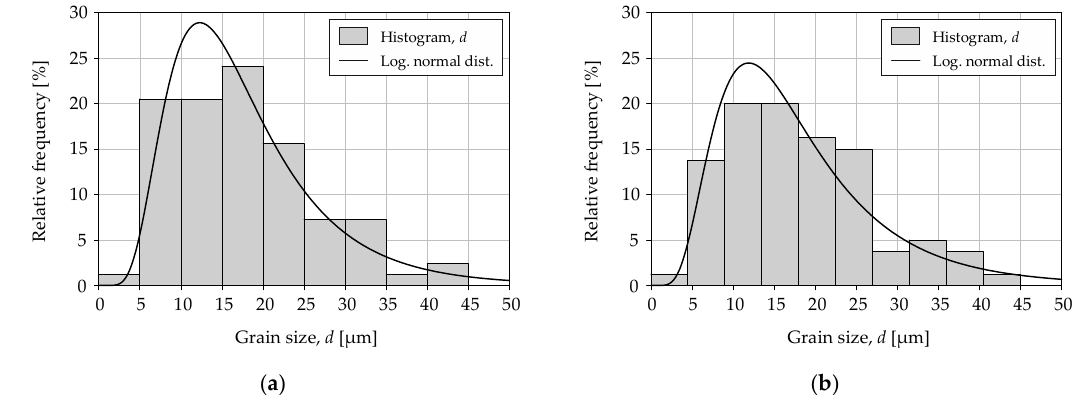
Figure 6. Distribution of grain size d for 1.4301 steel with the following grain locations: ( a ) center; ( b ) 500 µm.